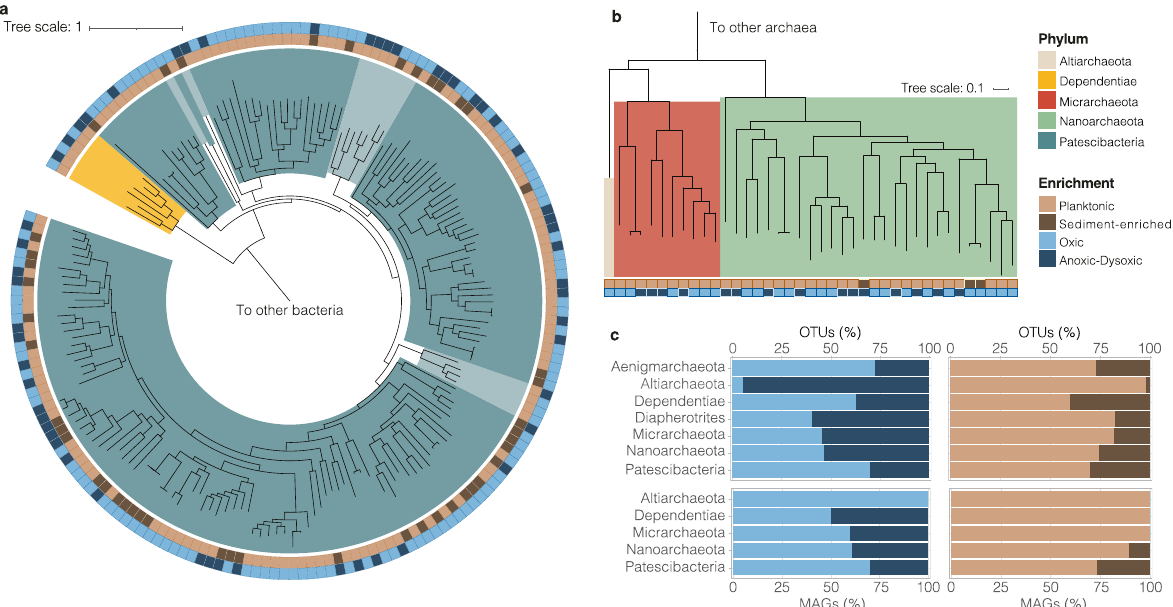
Fig. 2 Diversity of groundwater ultra-small microbial communities. Maximum likelihood phylogenetic trees of 177 unique ultra-small bacterial MAGs ( a ) and 39 unique ultra-small archaeal MAGs ( b ) recovered in this study. Outer rings indicate the site characteristics where MAGs were enriched. Enrichment factors were calculated as (average relative abundance in oxic and planktonic ultra-small microbial communities, respectively)/(average relative abundance in anoxic-to-dysoxic or sediment-enriched microbial communities, respectively). Trees are based on either 120 concatenated bacterial marker genes or 122 concatenated archaeal marker genes from GTDB-Tk, and were rooted to other groundwater bacterial and archaeal MAGs, respectively (Table S3). Scale bars indicate the number of substitutions per site. Branch background shading denotes Patescibacteria classes (clockwise): Gracilibacteria, Saccharimonadia, UBA1384, Dojkabacteria, Microgenomatia, Doudnabacteria, ABY1, Paceibacteria_A and Paceibacteria. c Proportion of ultra-small microbial OTUs (top) and MAGs (bottom) enriched in low and high oxygen groundwater, and in planktonic and sediment-enriched samples (Table S1). Enrichment factors were calculated as described